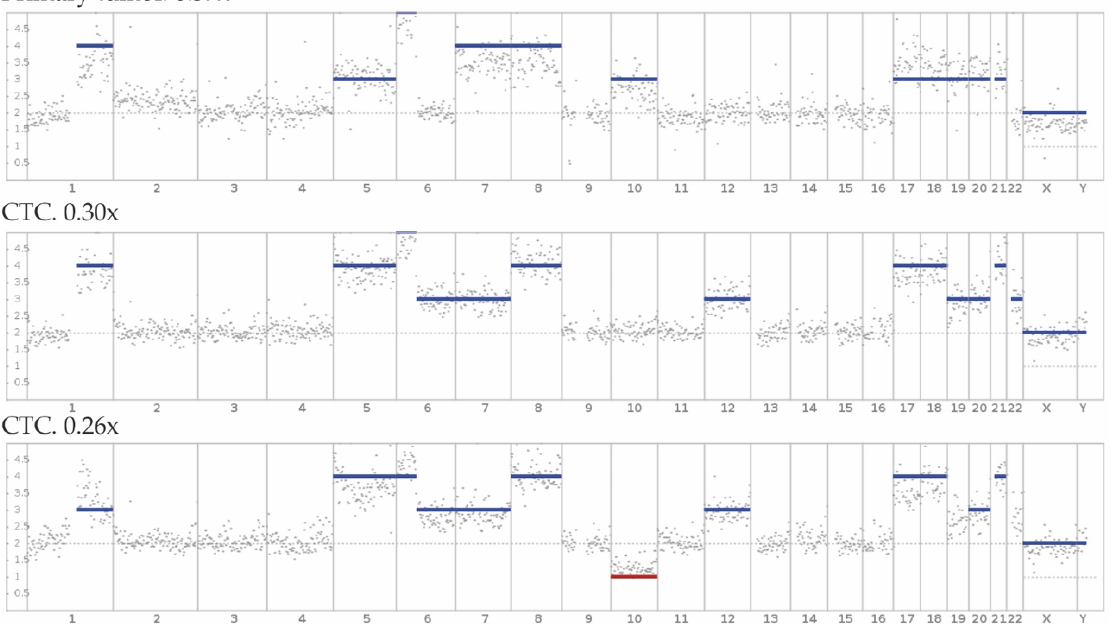
Figure 2. Modified from Beasley et al. [26] showing CNV-profiles derived from the primary tumor (FFPE tissue) and CTCs isolated from 10 mL peripheral blood of the same patient after whole genome amplification and shallow Whole Genome Sequencing (genomic coverage: 0.37×, 0.30× and 0.26×, respectively).